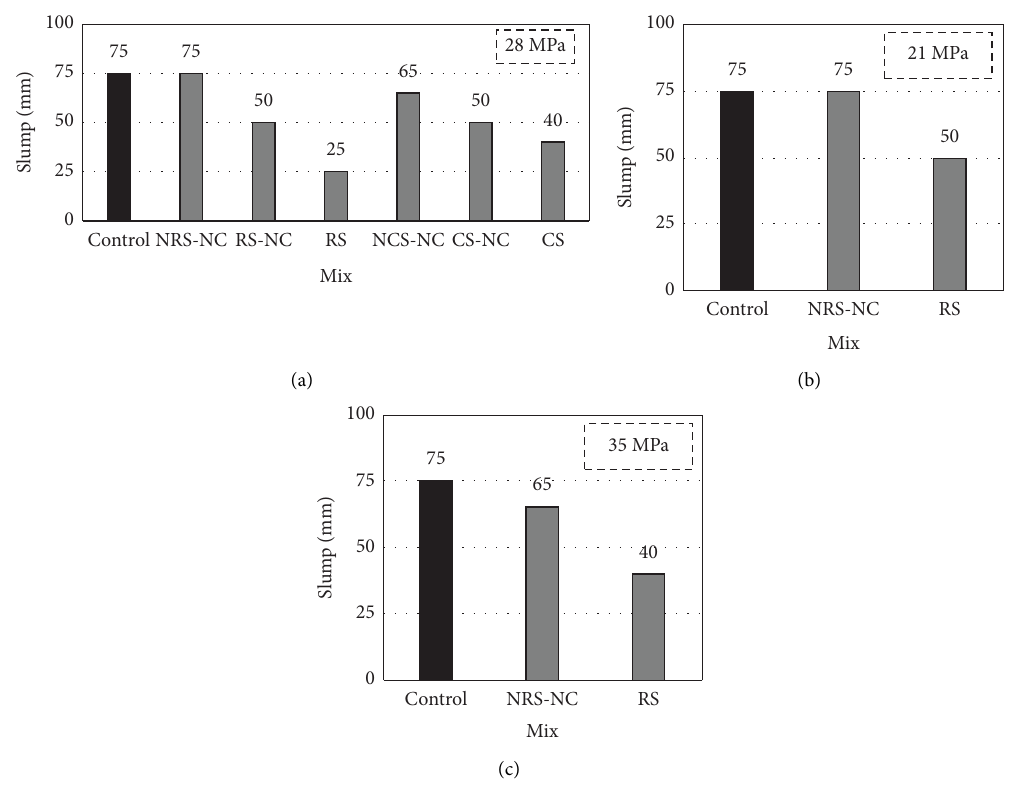
Figure 5: Slump test results: (a) for 28MPa, (b) for 21 MPa, and (c) for 35MPa